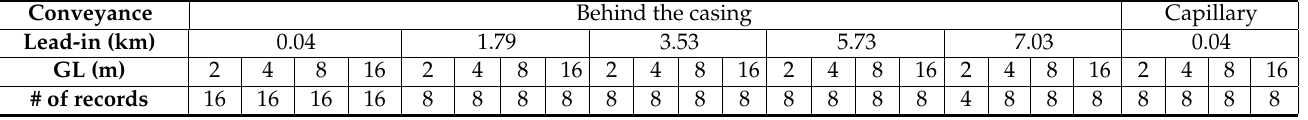
Figure 1. ( a ) Schematic representing survey geometry. Vibroseis truck located 37 m away from the wellhead generated seismic waves captured by fiber-optic cables installed along ~440 m well interrogated by an interrogator unit (IU) shown in orange. ( b ) Example of seismic data recorded by DAS after correlation with vibroseis sweep. Direct P-wave, direct S-wave, and example of one of the reflected P-P wave arrivals are indicated. ( c ) The compressional sonic log data in terms of slowness as measured by the sonic logging tool. Note that the vertical scale is the same for all subplots. Table 1. Summary of data acquisition